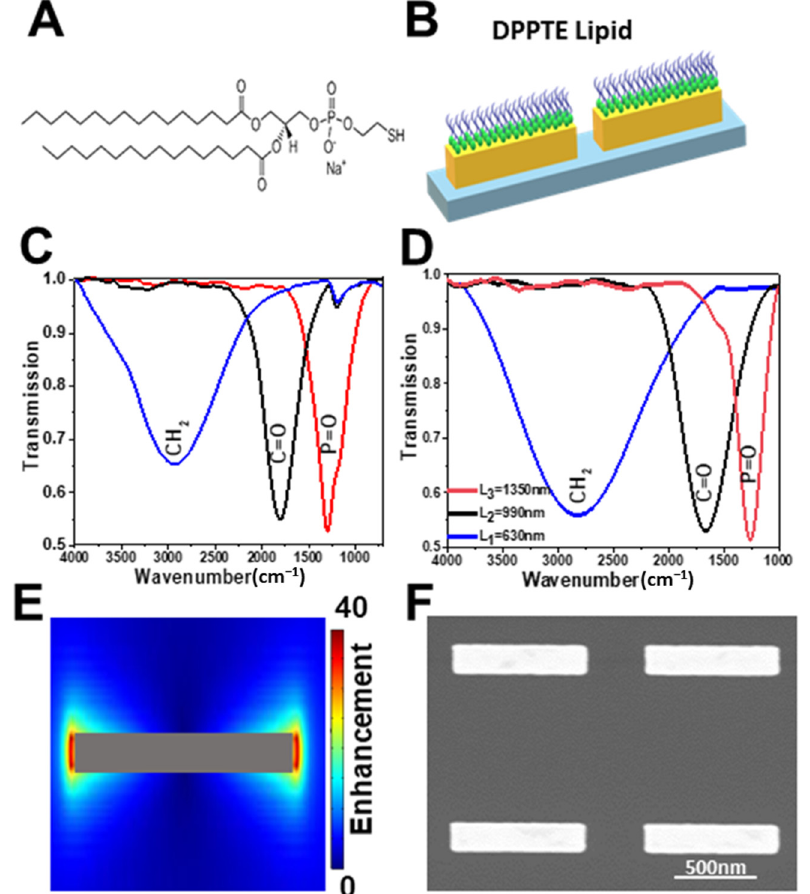
Figure 1. ( A ) Structure of the DPPTE (1,2-dipalmitoyl-sn-glycero-3-phosphothioethanol, sodium salt). ( B ) Schematic representation of the DPPTE thiolipid attached to the nanoantennas. ( C ) Measured relative transmittance of gold nanoantenna arrays of different lengths (L1 = 630 nm, L2 = 990 nm, L3 = 1350 nm) while the height and the width are h = 100 nm and w = 150 nm. These different lengths of the nanoantennas were used to target the spectral regions associated with CH 2 symmetric and antisymmetric stretching, C=O stretching, P=O antisymmetric stretching modes of the lipid as indicated by blue, black and red lines, respectively. ( D ) Simulated relative transmittance spectra of gold nanoantennas. ( E ) Electric field (E/E0) enhancement. The color scale (shading) indicates the magnitude of the enhancement. ( F ) Scanning electron microscopy (SEM) image of a selected antenna array with a length of 900 nm fabricated on a Si